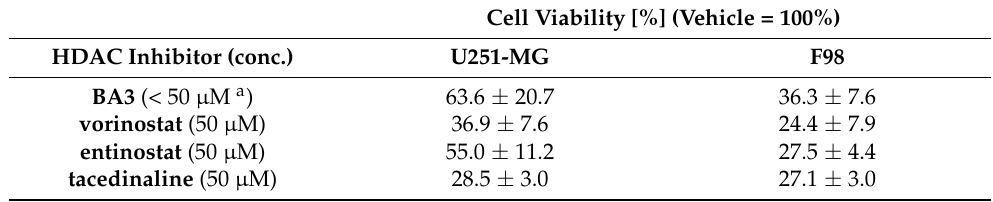
Table 3. Effect of BA3 and reference HDAC inhibitors on cancer cell viability. Viability of rat F98 glioma cells and human U251-MG glioblastoma cells was measured by MTS assay (CellTiter 96 ® AQueous One Solution Cell Proliferation Assay; Promega GmbH, Walldorf, Germany) after incubation with <50 µ M BA3 or 50 µ M reference HDAC inhibitors for 72 h. The results are expressed in relation to vehicle (0.5% DMSO, considered as 100% viability) as the mean percentage ± standard deviation ( n = 3; each experiment performed in quintuplicate). Cell Viability [%] (Vehicle = 100%) HDAC Inhibitor